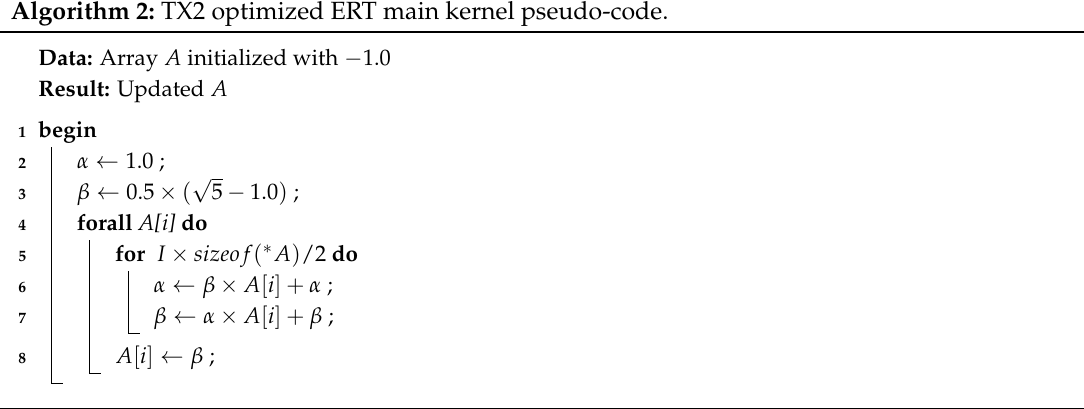
Algorithm 2: TX2 optimized ERT main kernel